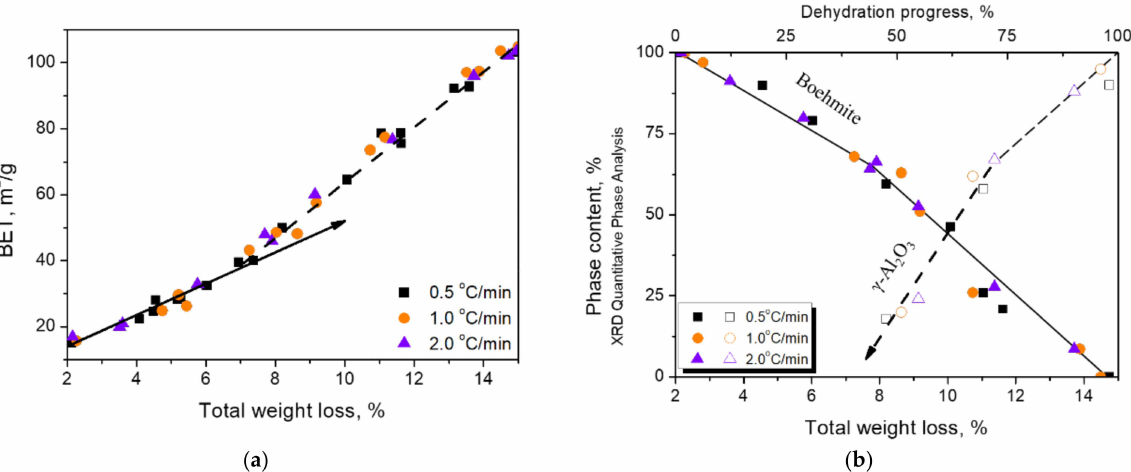
Figure 3. Two stages of BET value increments with the weight loss ( a ). Correlation between the phase contents of boehmite and γ -Al 2 O 3 and weight loss ( b